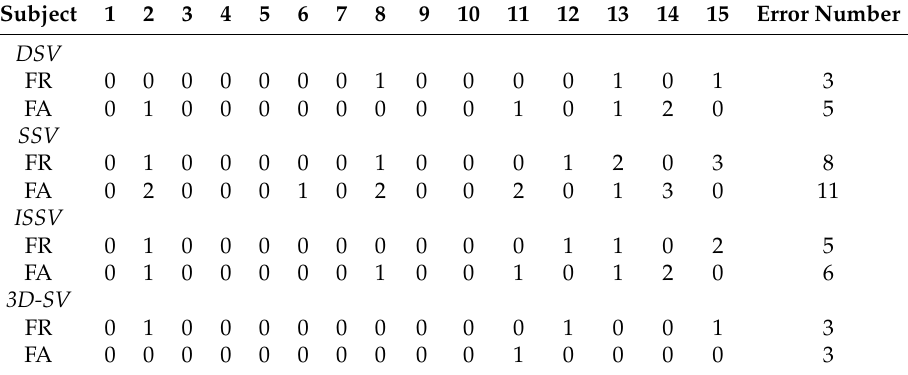
Table 2. The table shows the results of the four verification modules on our dataset. The number of false rejections (FR), false acceptances (FA), and total errors are provided for each of the 15 users. The 3D-SV module shows the least number of FA, while its number of FR is equivalent to the DSV